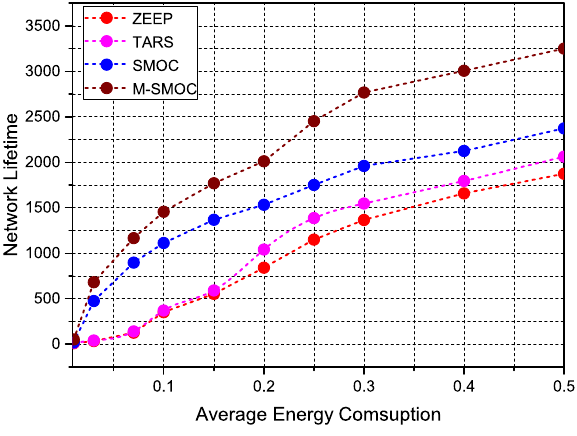
Figure 6. Comparison of the network lifetime in terms of energy